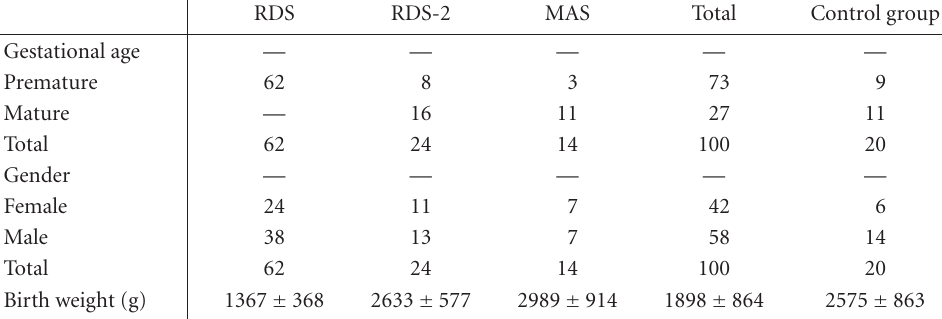
Table 1: Demographic characteristics of the patient and control